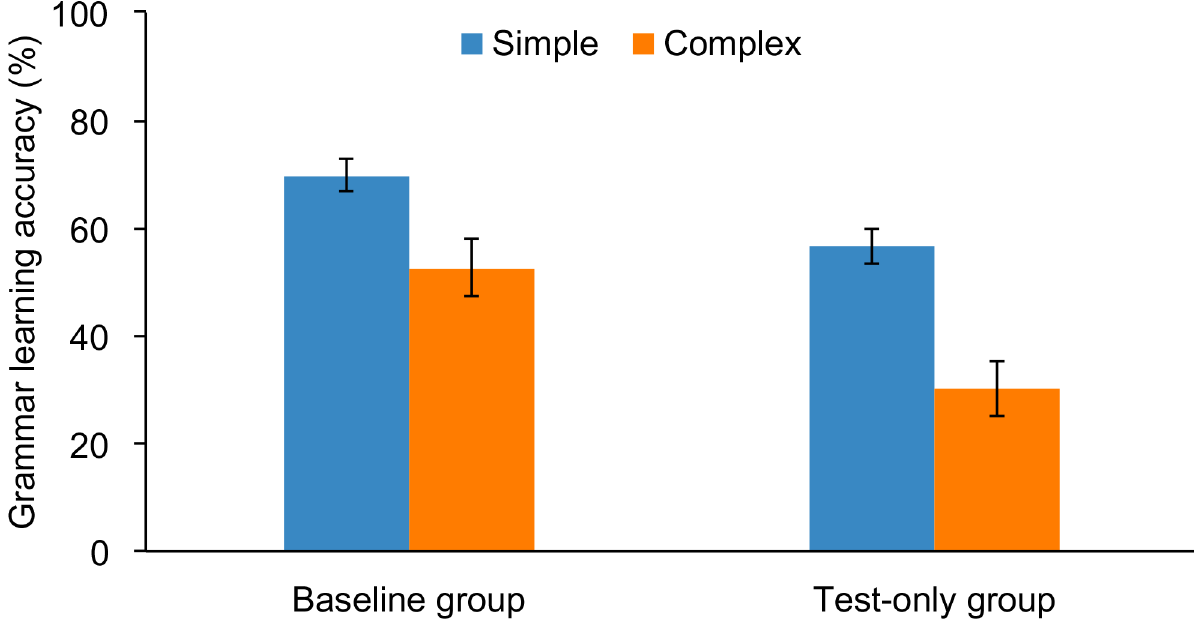
Fig 1. Grammar learning accuracy (%) of simple and complex grammar rules by subjects who underwent passive, exposure- based training + test (baseline group) versus those who immediately completed the test without first undergoing training (test- only group). Errors bars depict the standard error of the mean.